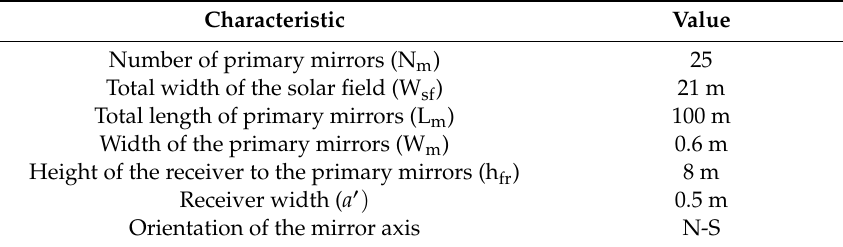
Table 1. Geometric data of a FRESDEMO similar field.